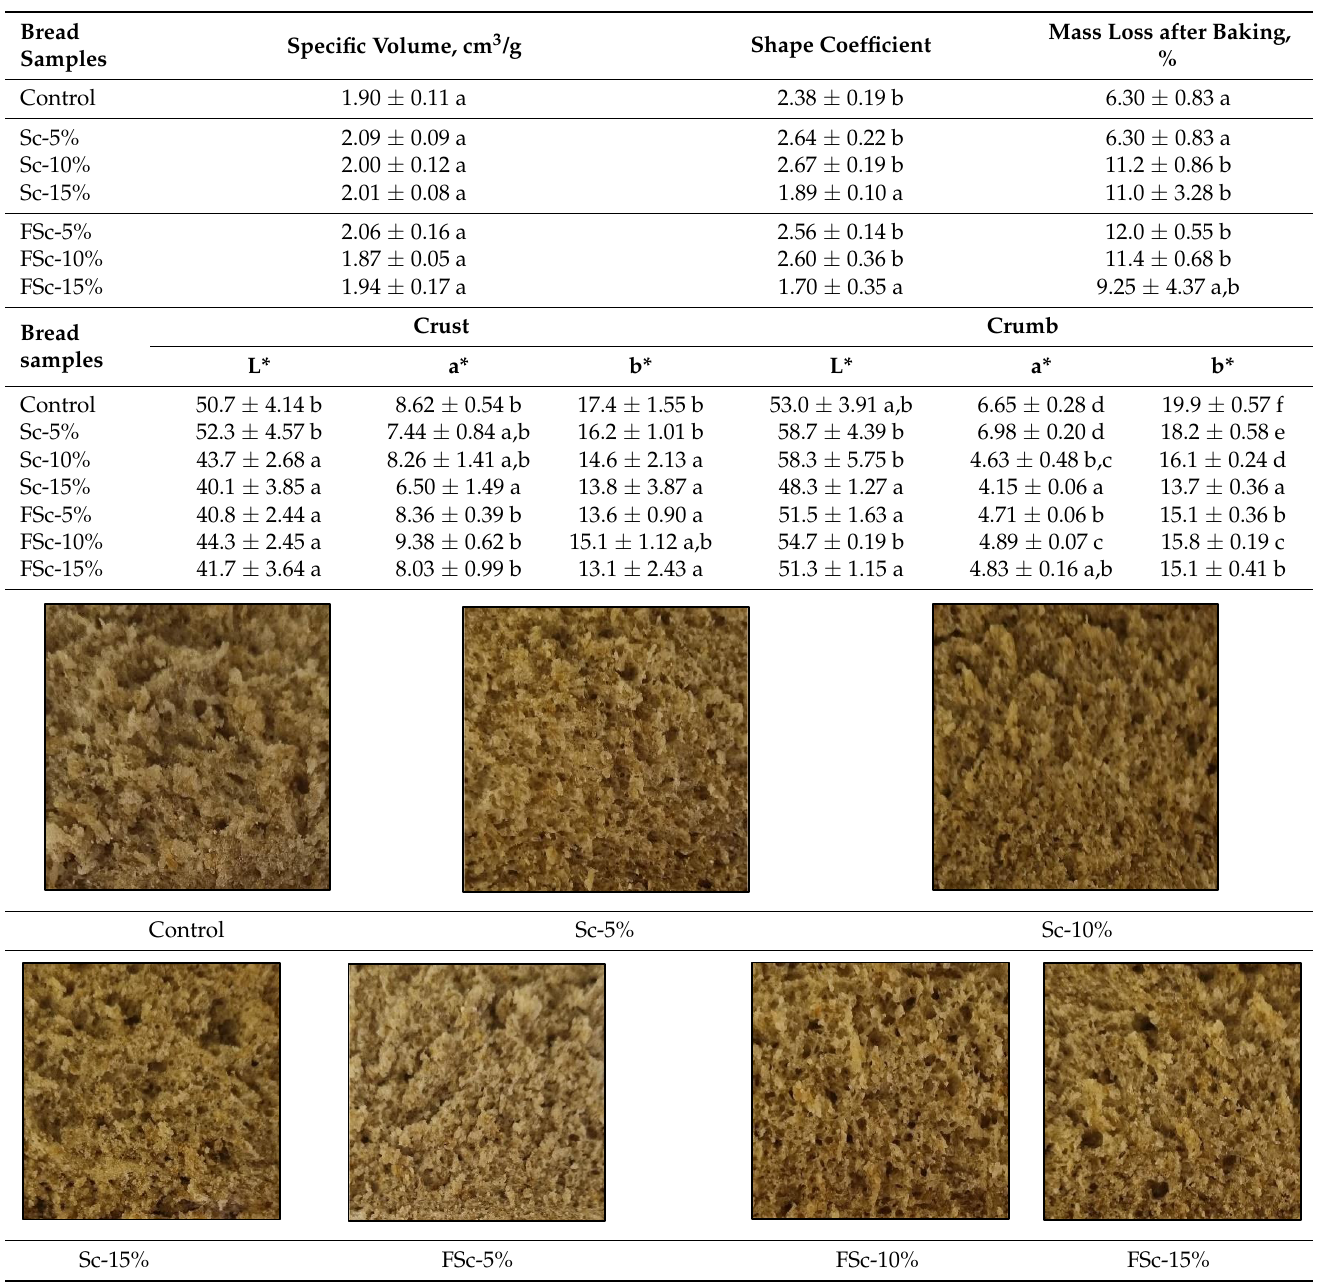
Table 5. Bread specific volume, porosity, shape coefficient, mass loss after baking, colour characteris- tics of the bread crust and crumb, and bread crumb images.